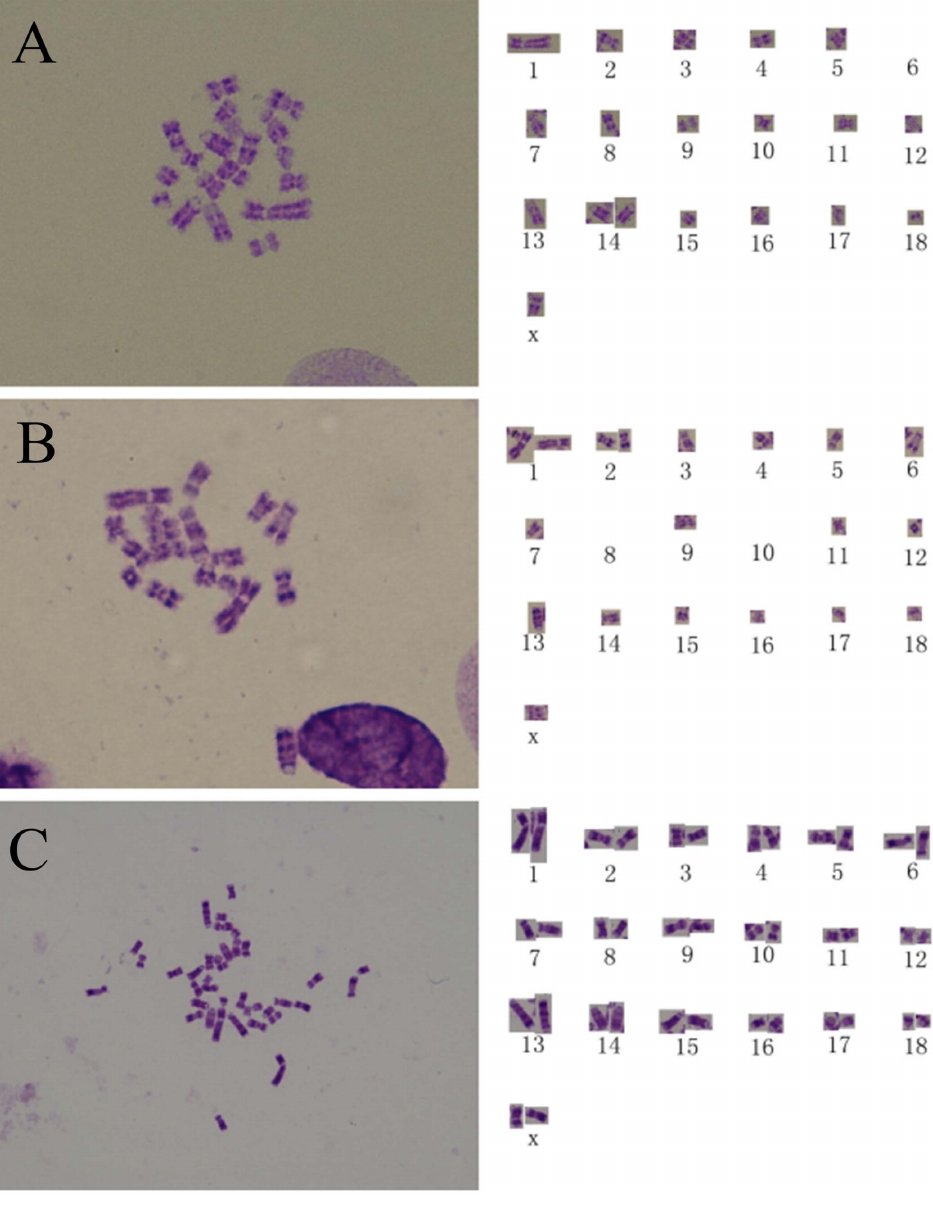
Table 3. The body size of day 30 porcine parthenogenetic fetuses derived from transfer of PA embryos to three gilts.